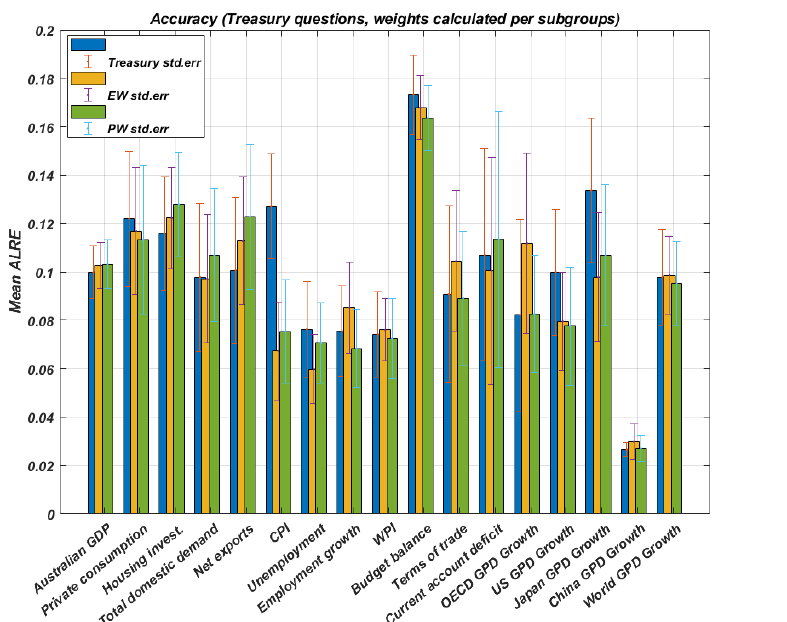
Figure 5. Comparative performance of treasury forecasts, the performance weighted (PW), and the equally weighted (EW), a.k.a.nominal group forecast for each of the 17 economic forecasts domain. The figure shows the mean ALRE of forecasts and standard error intervals.